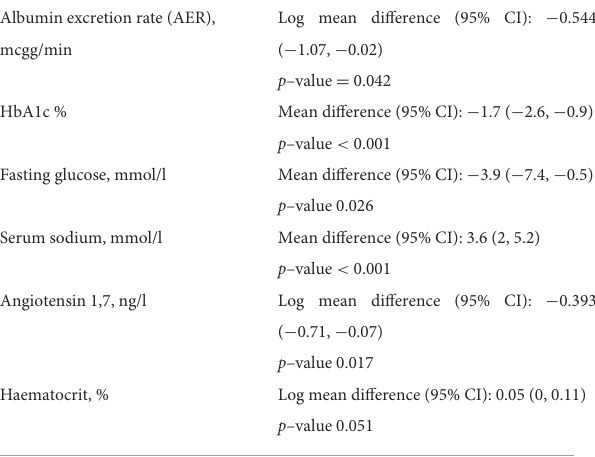
TABLE 3 Mean difference between Ramipril or Ramipril + Dapagliflozin treatment arms in primary endpoint and selected secondary endpoint variables at end of